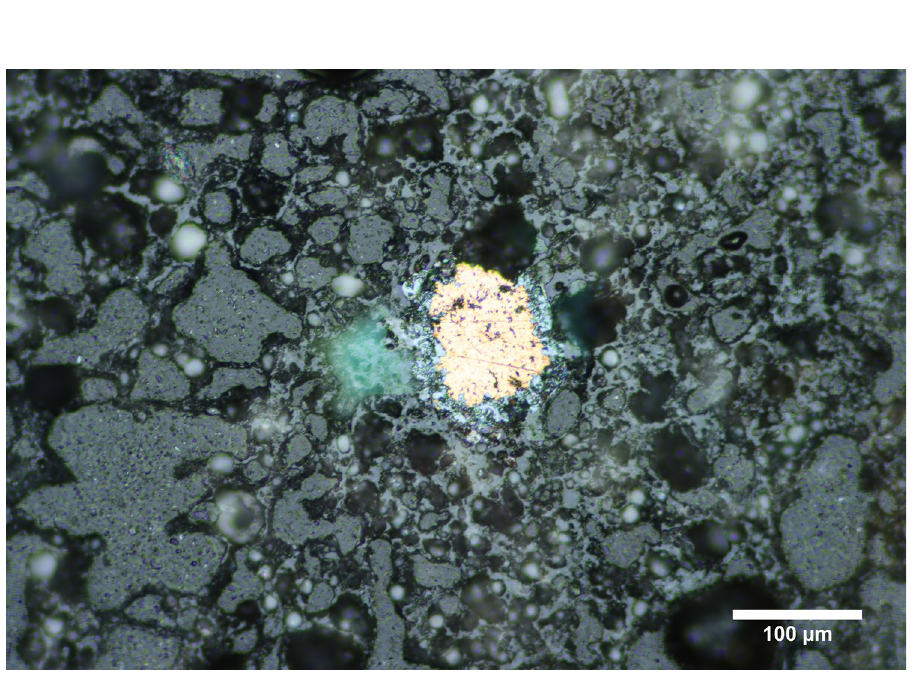
Fig 7. Photomicrograph of the copper prill in M-55. Photomicrograph of the copper prill within the walls of M-55. The copper color of the metal is visible in this reflected light image. Photomicrograph by Jennifer Meanwell.